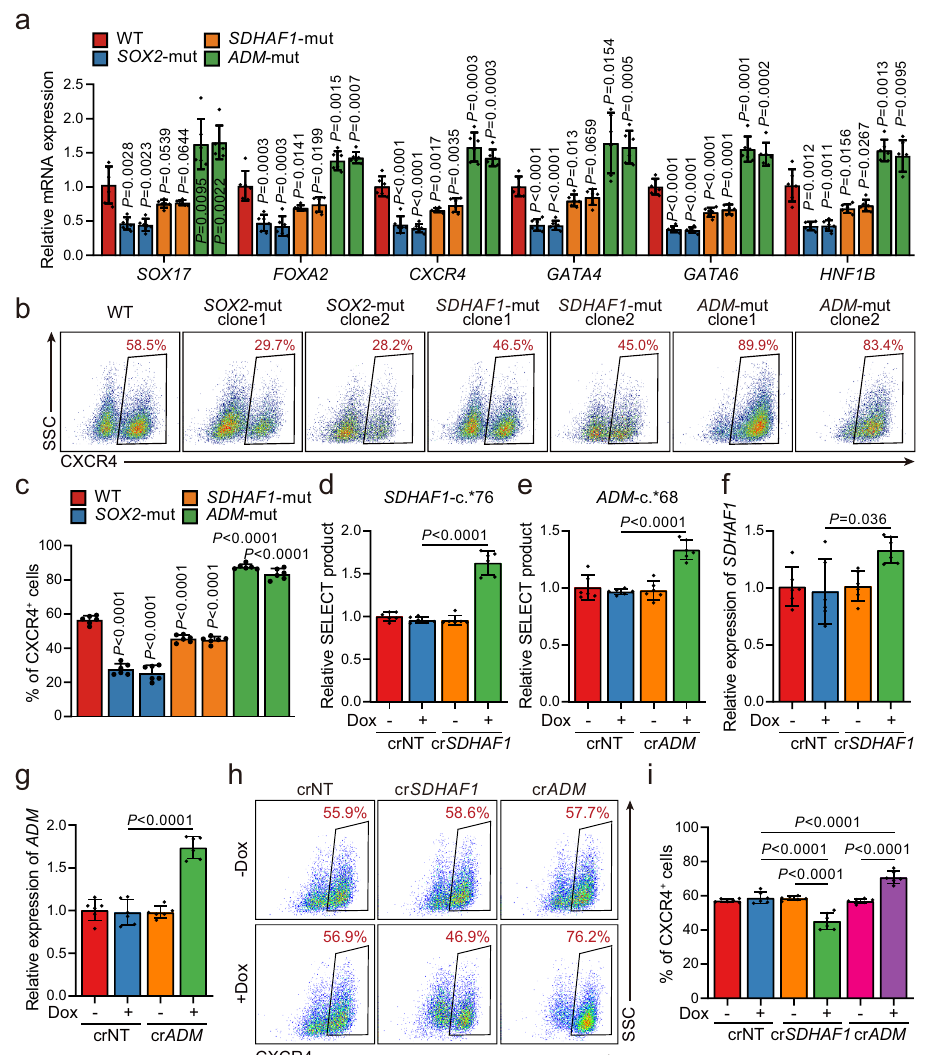
Fig. 5 Selected m 6 A-disruptive mutations regulate human endodermal speci fi cation through m 6 A. a mRNA levels of DE marker genes SOX17 , FOXA2 , CXCR4 , GATA4 , GATA6 , and HNF1B in cultures derived from WT, SOX2 -mut, SDHAF1 -mut, and ADM -mut as well as WT hESCs at day 3 of